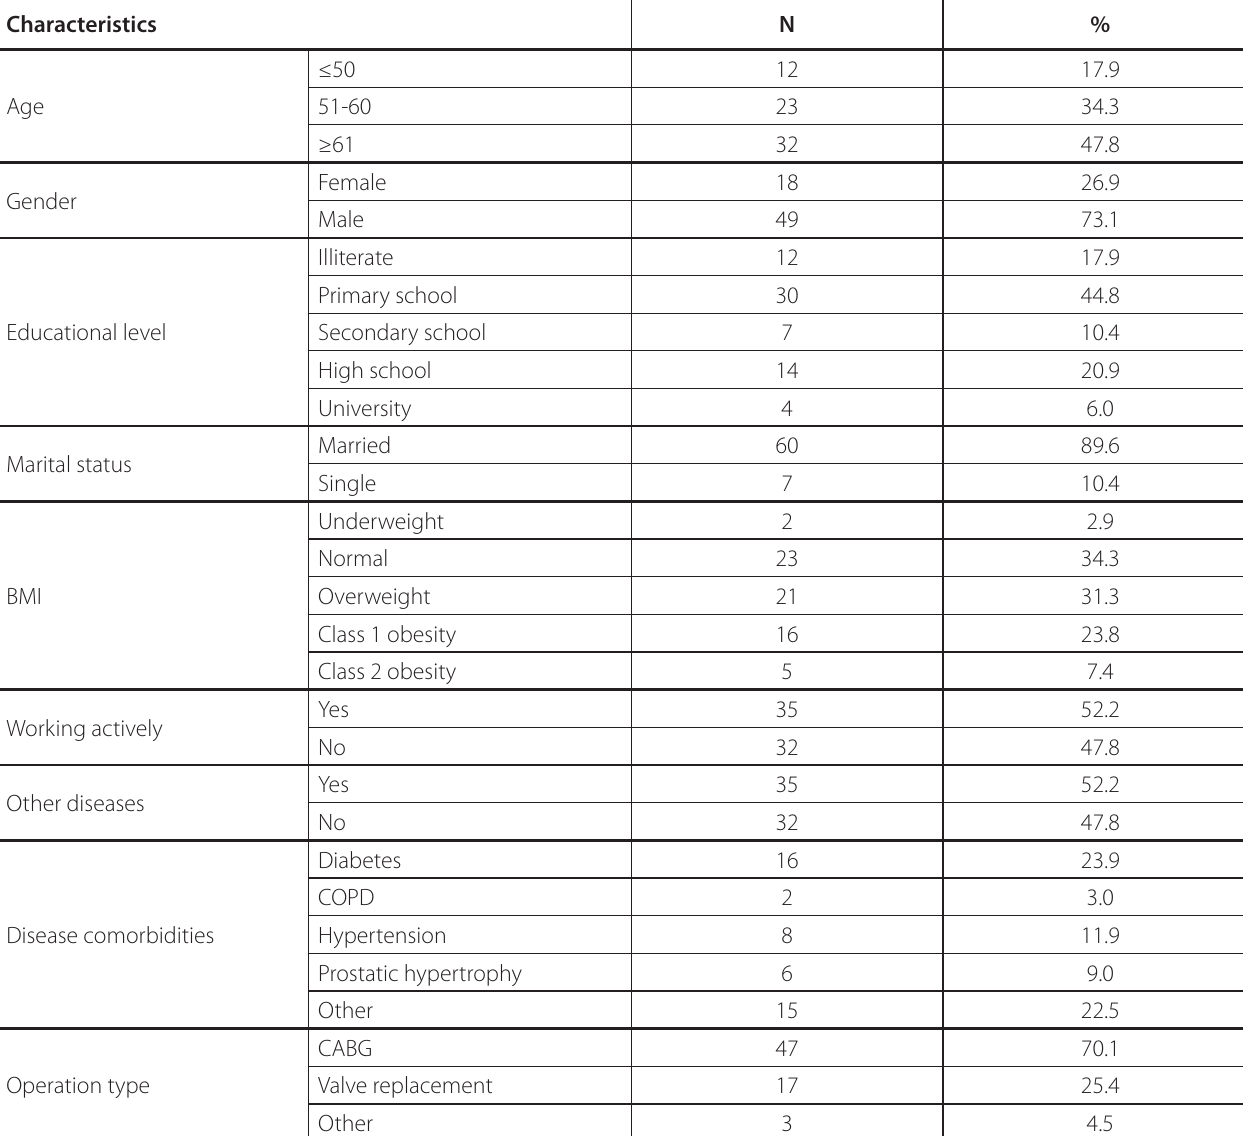
Table 1 . Demographic characteristics of patients